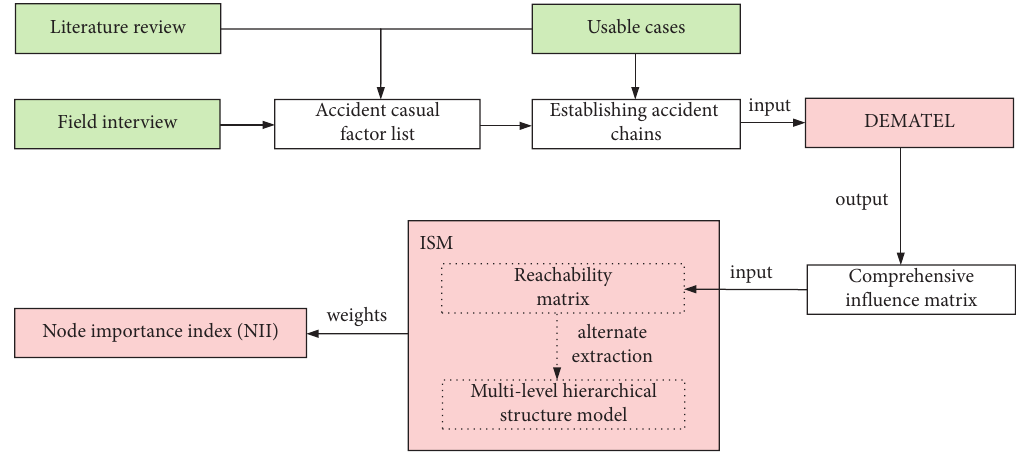
Figure 1: Framework of